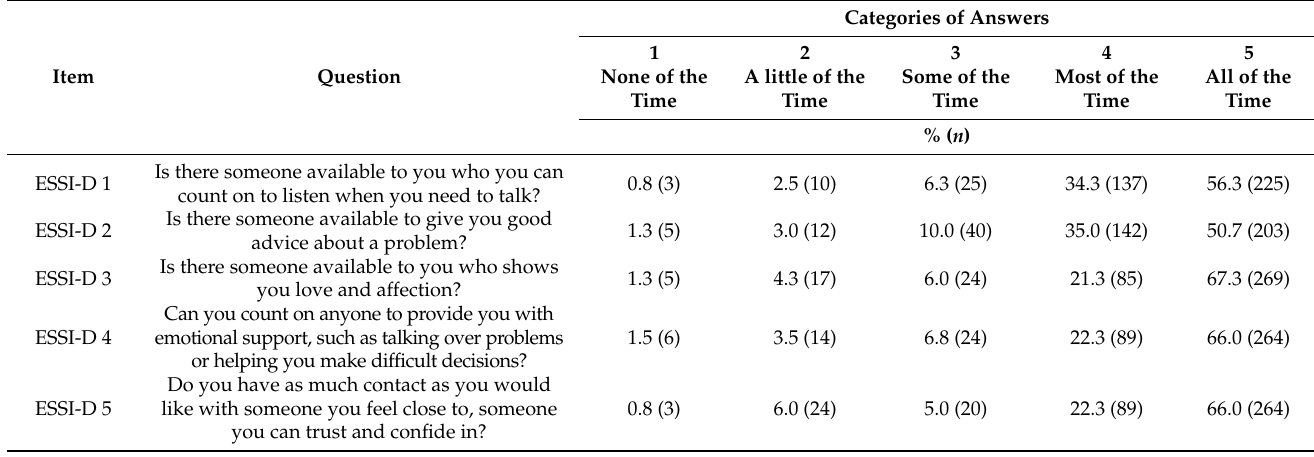
Table 2. Descriptive evaluation of ESSI-D-items; % = percentage, n = counts; N = 400, missing data due to incomplete ESSI-D questionnaires ( n = 23) or missing information regarding existence of a care level ( n = 4).